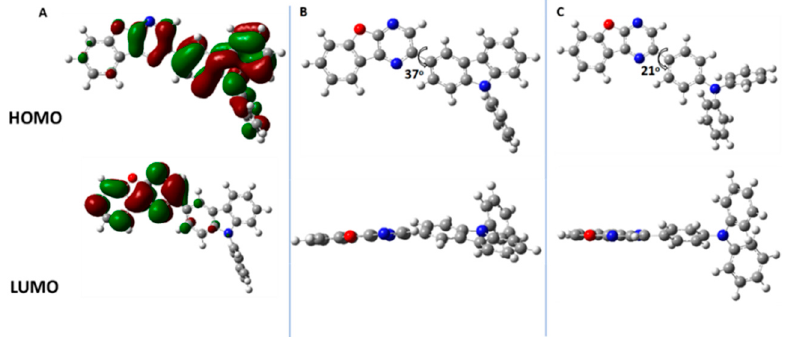
Figure 1. ( A ) Highest occupied molecular orbital (HOMO)/lowest unoccupied molecular orbital (LUMO) spatial distribution of BCz–BFPz; ( B ) top-view and side-view of BCz–BFPz optimized